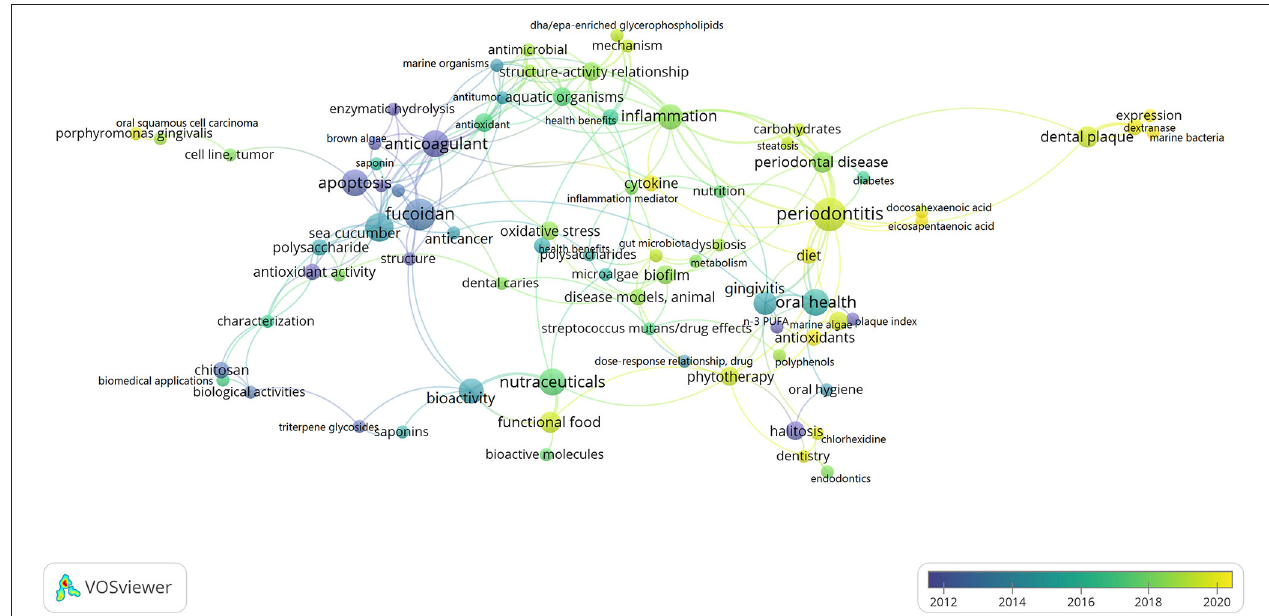
FIGURE 1 | Overlay visualization of keyword